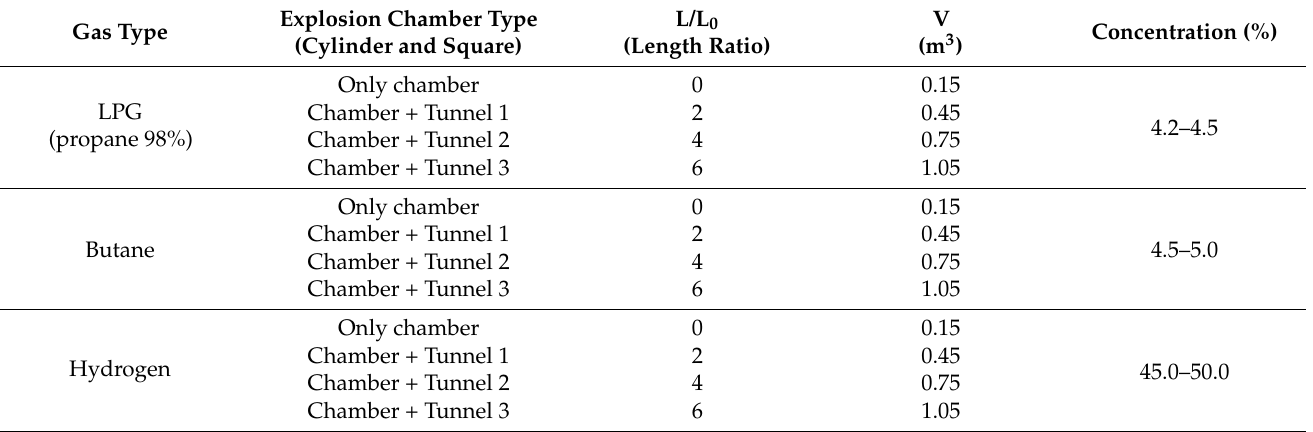
Table 2. Explosion experiment